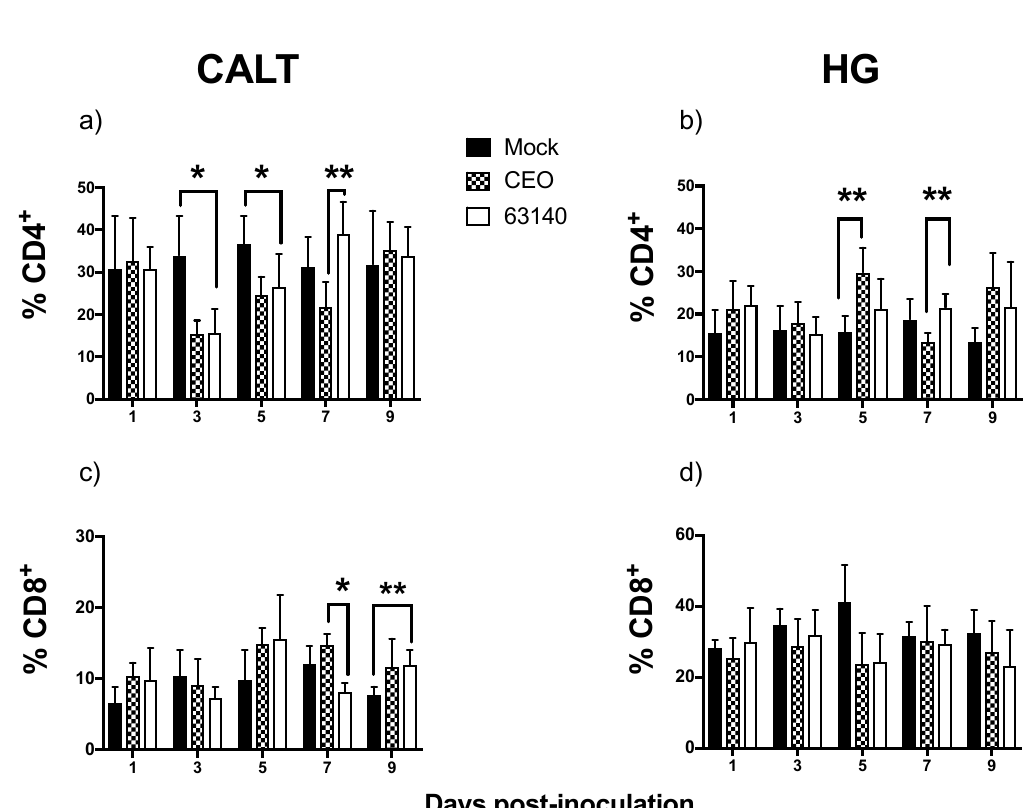
Figure 5. Percentages of CD4 + and CD8 α + cells in the conjunctiva-associated lymphoid tissue (CALT) and Harderian gland (HG) of chickens inoculated with the CEO vaccine strain and 63140 virulent strain. Percentage of CD4 + in CALT ( a ) and in HG ( b ); percentage of CD8 + in CALT ( c ) and HG ( d ) from 1 to 9 days post-CEO and 63140 inoculation. The one-way analysis of variance, Kruskal–Wallis test and the Dunn´s multiple comparison post-test ( p ≤ 0.05) were performed to individually compare CD4 + and CD8 α + cell percentages in CALT and HG for the mock-, CEO,- and 63140-inoculated groups. The mean percentage is indicated by bars and vertical lines represent the standard deviation (SD). Significant increase in CD4 + and CD8 α + cells is indicated by (**), and significant decrease by (*) ( p ≤ 0.05).